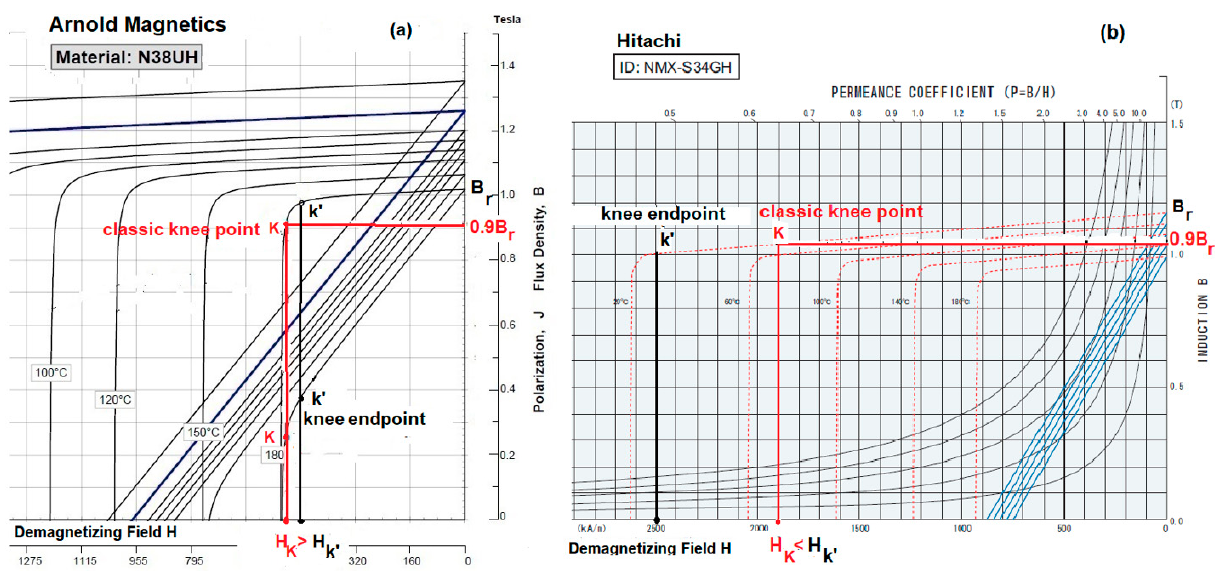
Figure 1. ( a ) For Arnold’s N38UH, the knee flux densities B k ′ , B K differ by ~50%. ( b ) For Hitachi’s NMX-S34GH, the knee fields H k ′ , H K differ by 30%. Therefore, the knee endpoint k ′ differs significantly from the classic knee point K.